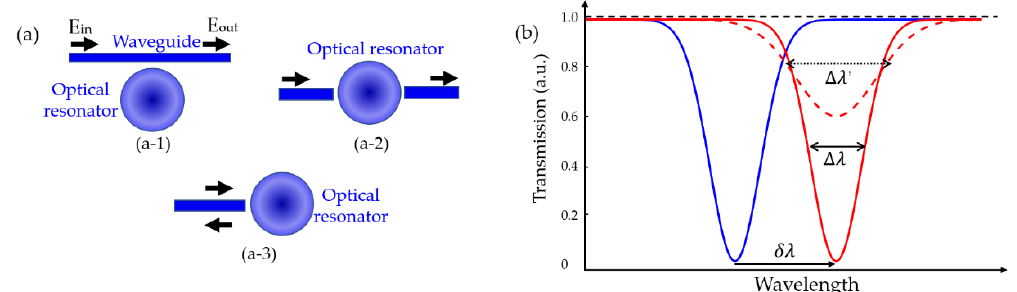
Figure 2. ( a ) Configurations of waveguide-resonator coupling: ( a - 1 ) waveguide (WG) side-coupled [88], ( a - 2 ) double side-coupled [89], and ( a - 3 ) single side-coupled [90]; ( b ) a characteristic dip at resonance wavelength for WG side-coupled cavity. The resonance shifts from blue line to red line due to perturbation, and a linewidth broadening Δλ ’ −Δλ leads to a decreasing Q-factor [29] .